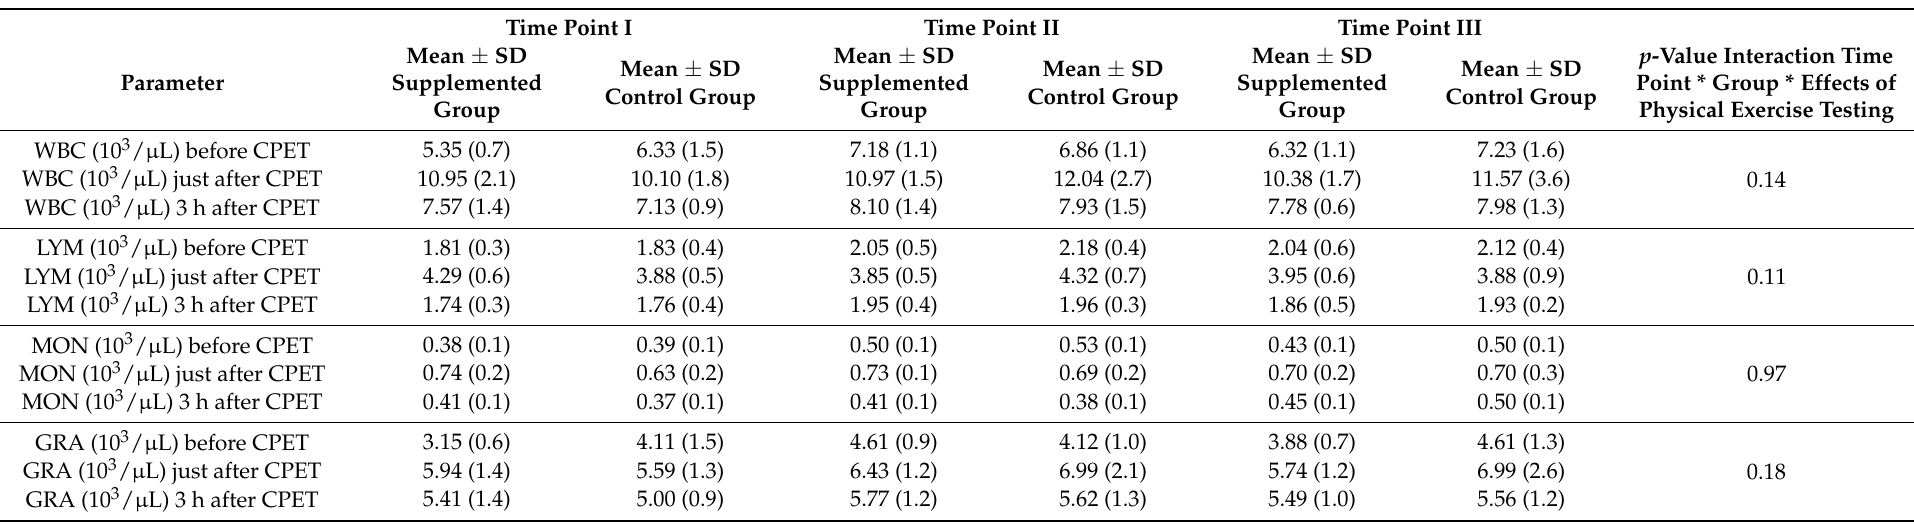
Table 5. Effects of supplementation on immune system function